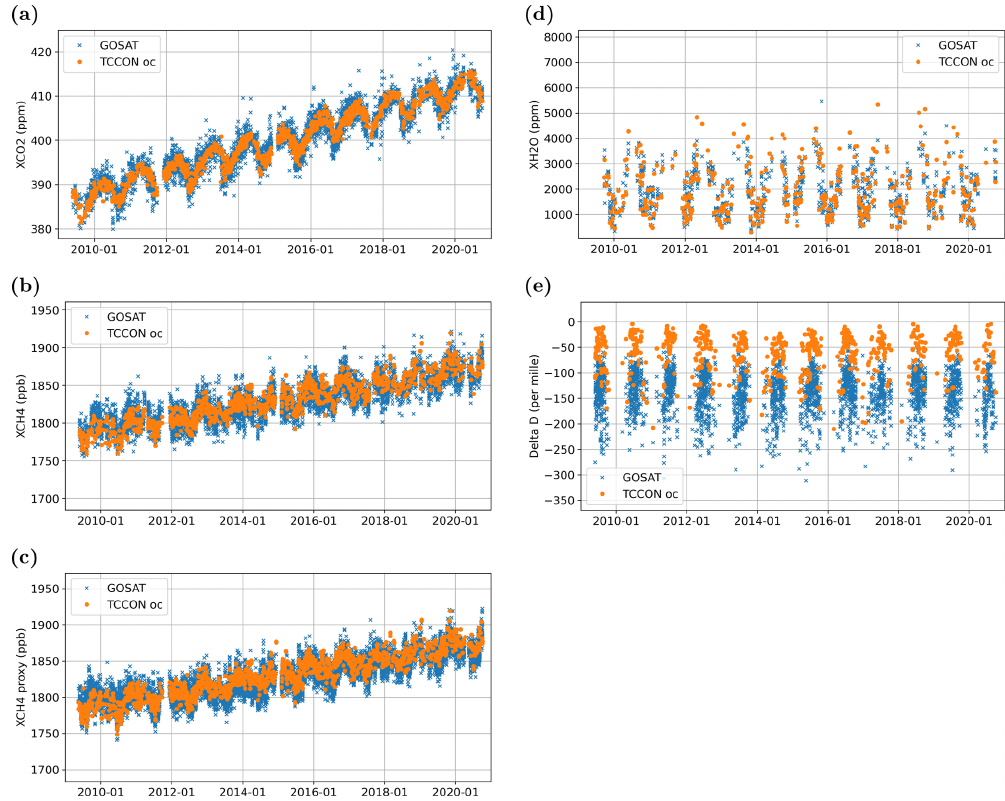
Figure 15. Example time series of TCCON and GOSAT FOCAL data at Lamont (station code oc). (a) XCO 2 ; (b) XCH 4 full-physics product; (c) XCH 4 proxy product; (d) XH 2 O; (e) δ